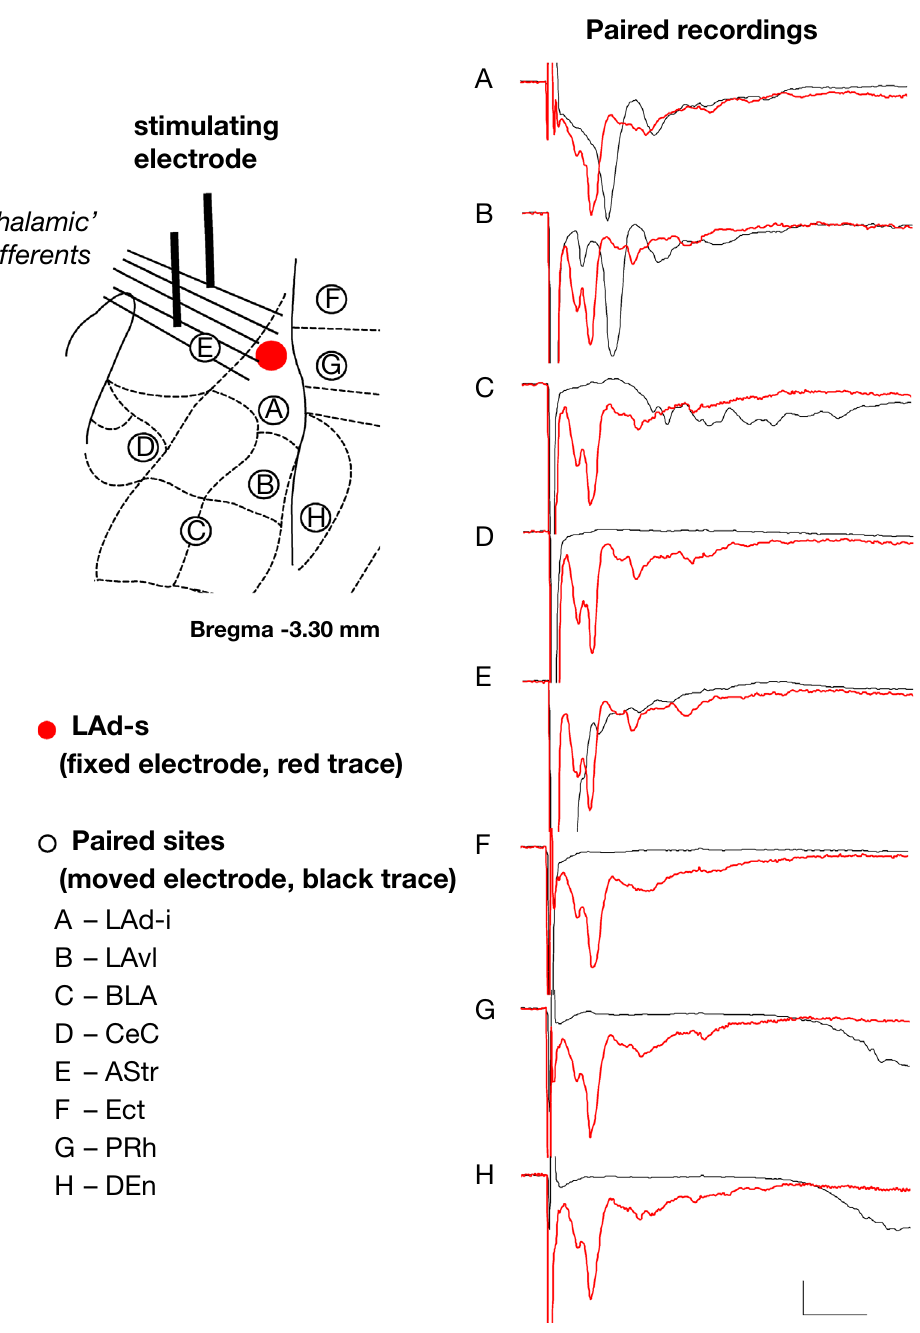
Figure 2 | Spatial properties of the FP in LAd-s and adjacent sites after stimulation of thalamic afferents. In order to ascertain the degree of temporal overlap of evoked potentials occurring in sites adjacent to the LAd-s, paired recordings of FP were made with a fi xed recording electrode in the LAd-s (red dot) and another recording electrode that was moved to eight adjacent sites (numbers A–H). Recording sites adjacent to the LAd-s in sequential order: (A) inferior lateral amygdala dorsal subnucleus (LAd-i); (B) lateral amygdala ventral lateral subnucleus (LAvl); (C) basal amygdala nucleus (BLA), (D) capsular division of the central amygdala nucleus (CeC), (E) amygdala striatal area (AStr), (F) ectorhinal cortex (Ect), (G) perirhinal cortex (PRh), (H) dorsal endopiriform nucleus (Den). FP recorded simultaneously from LAd-s (red traces) and from the numbered site of recording (black traces) are superimposed. Note the delayed latency of thalamic evoked synaptic activity in cortical structures (G–H). For more ventral amygdala locations and medial structures, thalamic evoked polysynaptic activity was observed (A–C, E). No peaks or counter peaks were observed that directly corresponded to those in the LAd-s. Qualitatively, the LAd-i FP was most similar to that observed in the LAd-s. Scale = 0.2 mV, 10